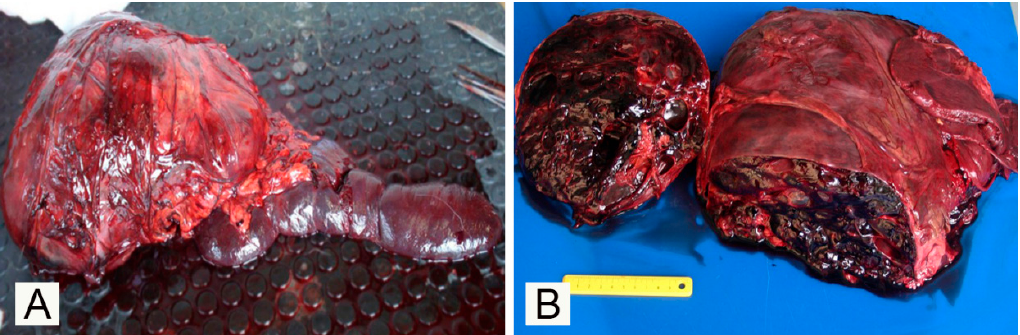
Figure 1. Gross presentation of the splenic mass in a nine-year-old male European wolf ( Canis lupus lupus ): ( A ) Gross presentation of the spleen with a focal round to oval mass bulging the splenic capsule; ( B ) On the cut surface, the splenic mass shows blood-filled cavernous spaces.